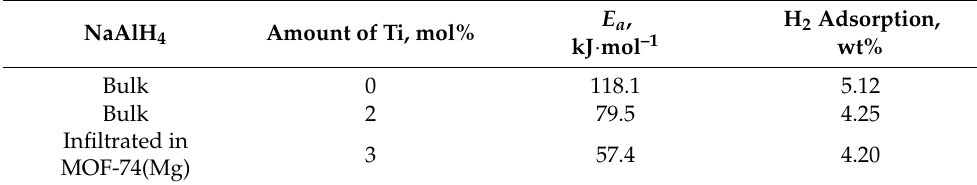
Table 4. Hydrogen adsorption capacity and activation energy of decomposition for nanoconfined and bulk NaAlH 4 . Hydrogen adsorption capacity was measured at 433 K and 105 bar of H 2 , and the mass of MOF-74(Mg) was excluded from the determination of the hydrogen amount. Reprinted with permission from [191]. Copyright © 2012, American Chemical Society. All rights